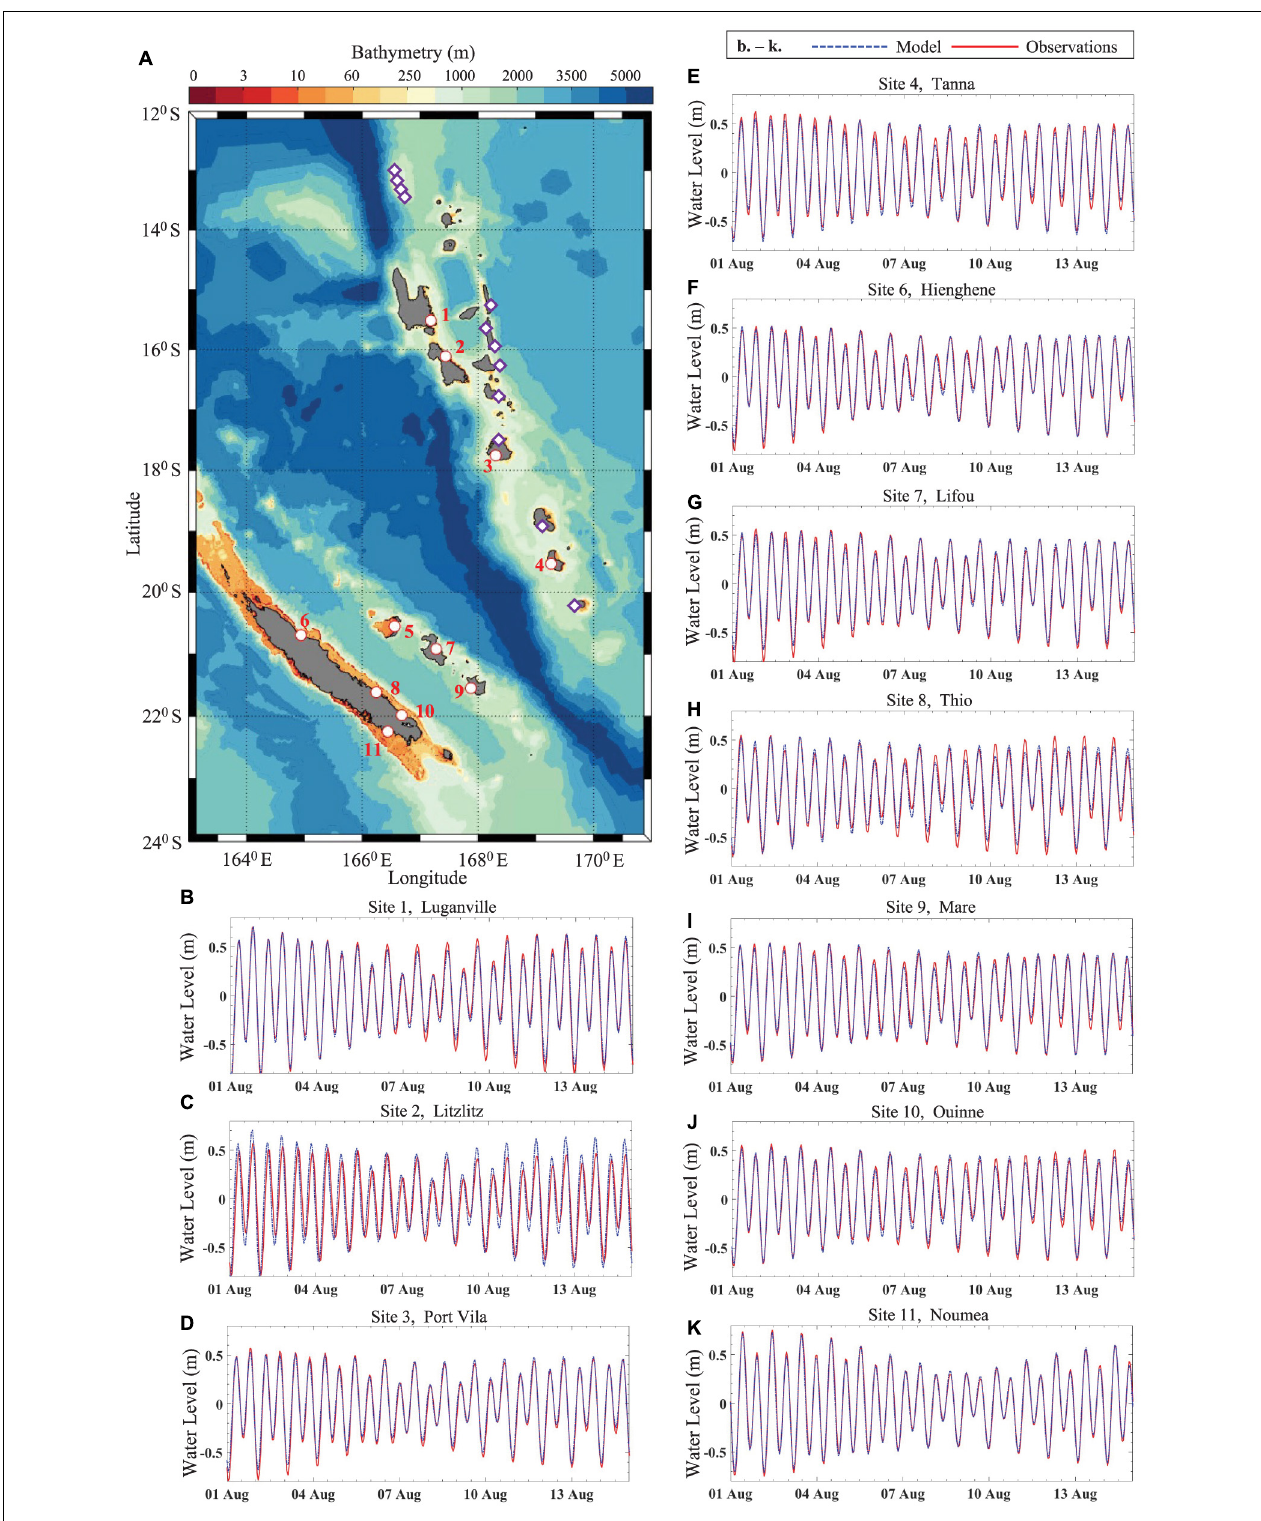
FIGURE 2 | Site map of tide gauge locations across Vanuatu and New Caledonia (A) . Tide gauge locations are highlighted using red and white circle markers, with red site number labels. Unmonitored locations where tidal characteristics were extracted are depicted using purple and white diamonds. Comparison between modelled water levels (blue) and observations (red) at ten of the eleven tide gauge locations (B–K) shown in panel (A) .